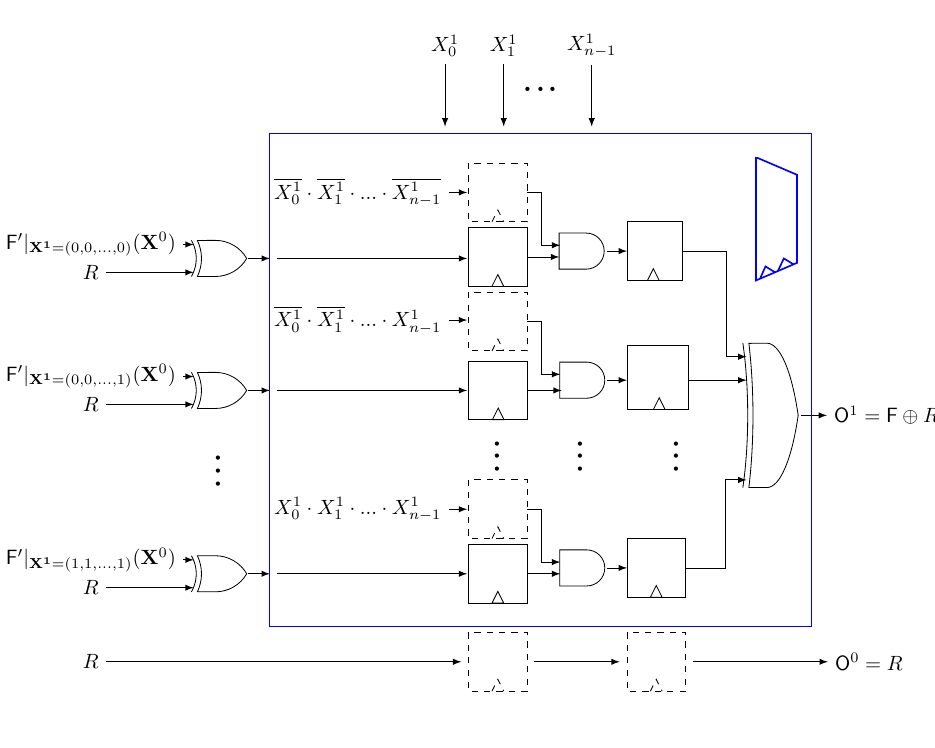
Figure 2: General GHPC